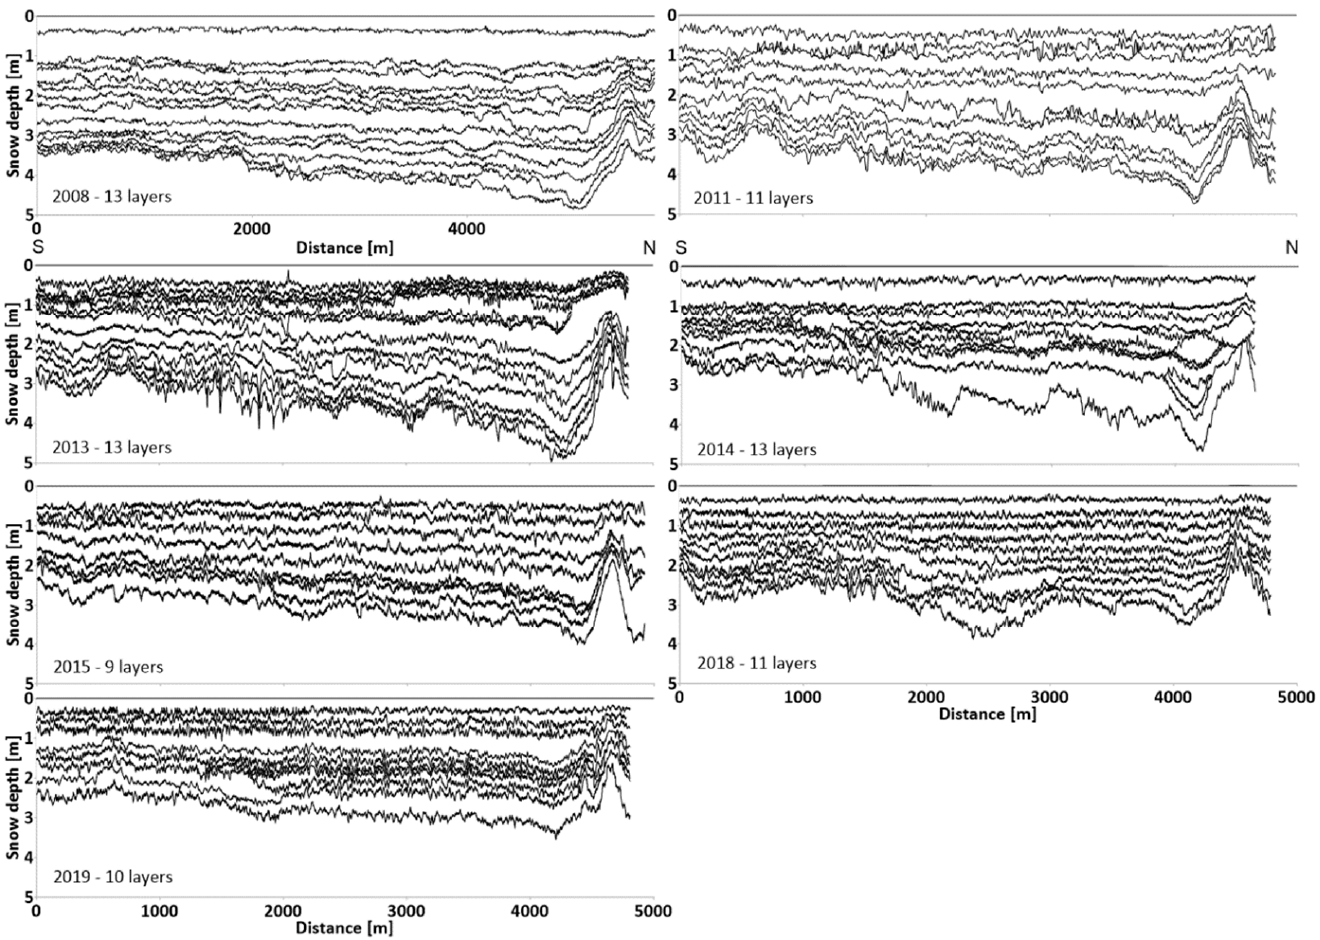
Figure 2. Snow cover layers distinguished on the GPR profiles. See the location of the GPR profiles on Figure 1.